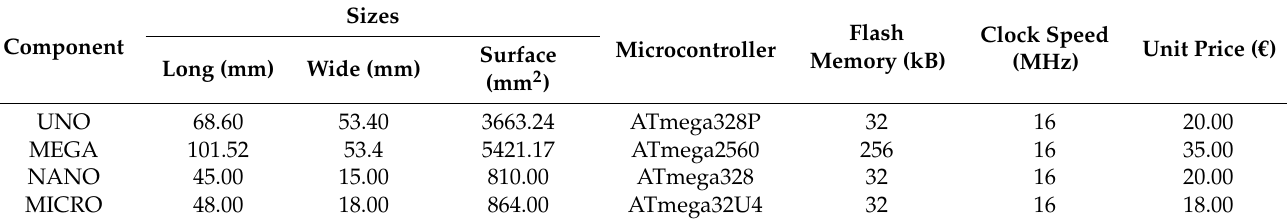
Table 1. Arduino family